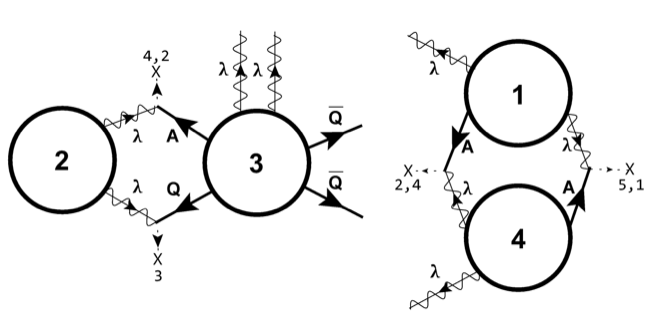
Figure 9: The multi-monopole composites for F = 1 on the baryonic branch when the gauge group breaks from SU ( 5 ) to Sp ( 4 ) . The antisymmetric and squark VEVs, (61) and (81), are represented as a cross with their color indices.